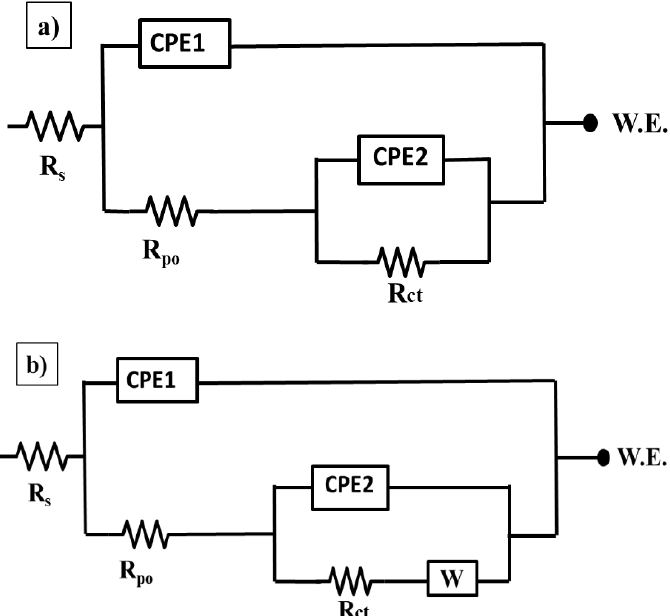
Figure 10. Equivalent circuits used to fit the impedance data for different epoxy coatings at different immersion times (( a ): the first two days of immersion time; ( b ): a higher immersion time (72, 96, and 120 h)) in 3.5 wt.% NaCl solution at room